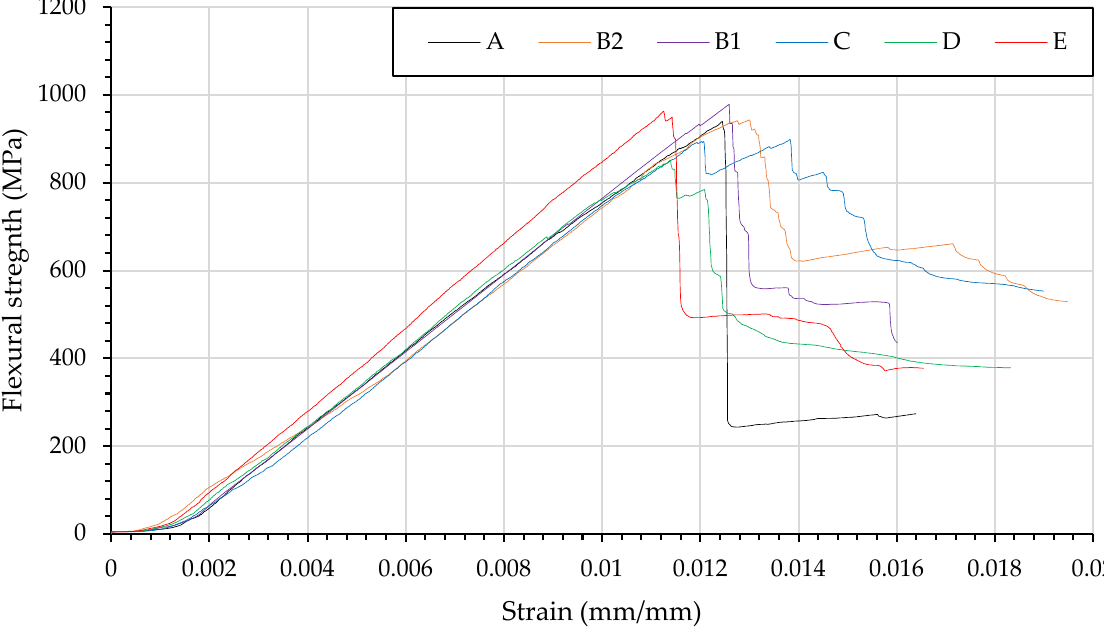
Figure 24. Stress strain curves of CFRP reinforced with PA 6,6 nanofibre (A) CF control sample; (B1) Single veil reinforcement compression layer of CFRP; (B2) Single veil reinforcement on tensile layer of CFRP; (C) Double compression layer of veil; (D) Double veil reinforcement on the neural axis and (E) Fully interlayered carbon fibre stack.